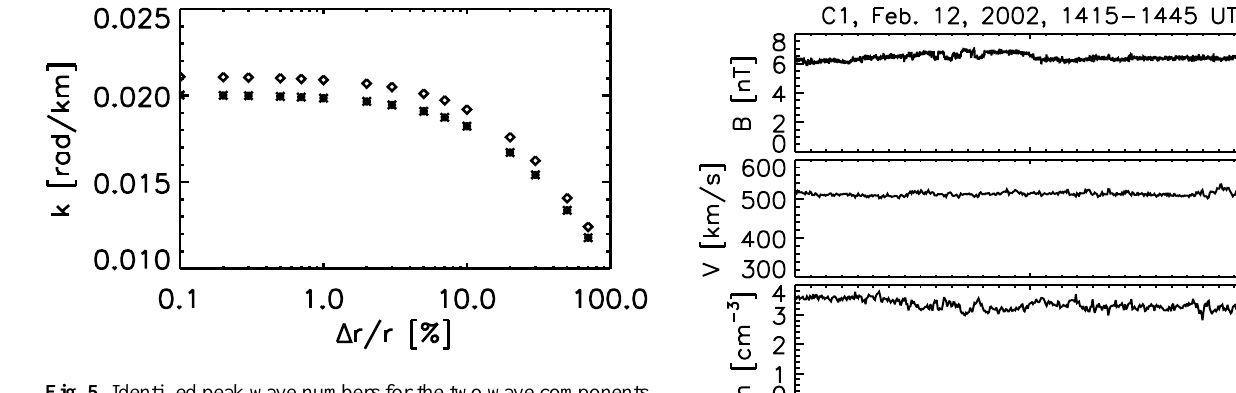
Fig. 5. Identified peak wave numbers for the two wave components for shifted sensor positions for the data set used in Fig. 4. The x- axis is the relative uncertainty of the sensor position in percentage.